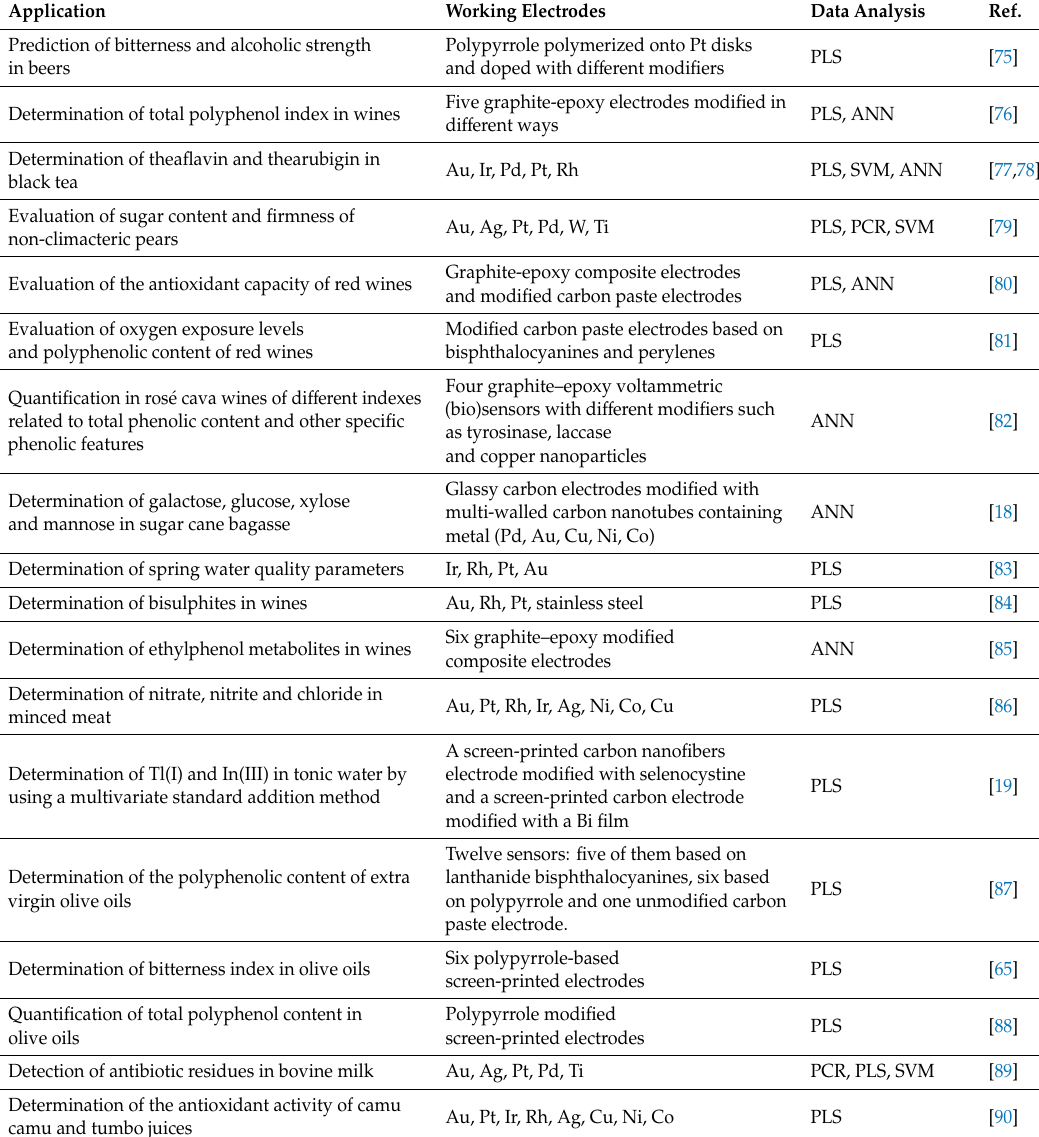
Table 2. Selected works dealing with the determination of chemical species and other quantitative parameters in food analysis by using voltammetric electronic